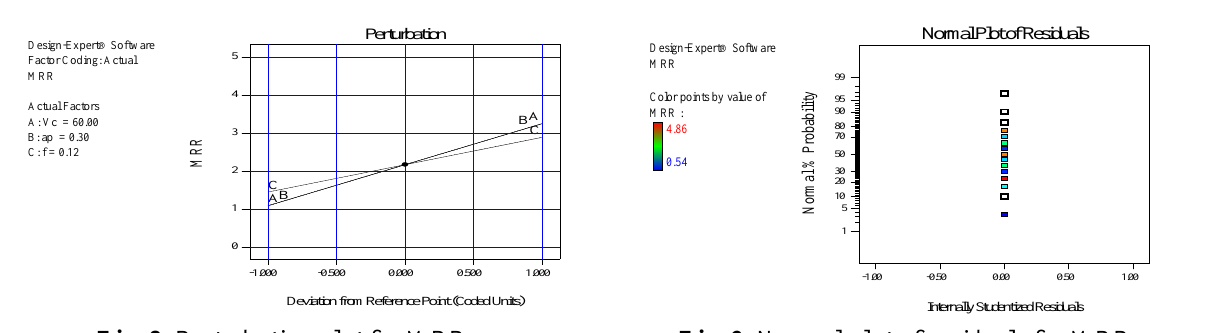
Fig. 8. Perturbation plot for MRR Fig. 9. Normal plot of residuals for